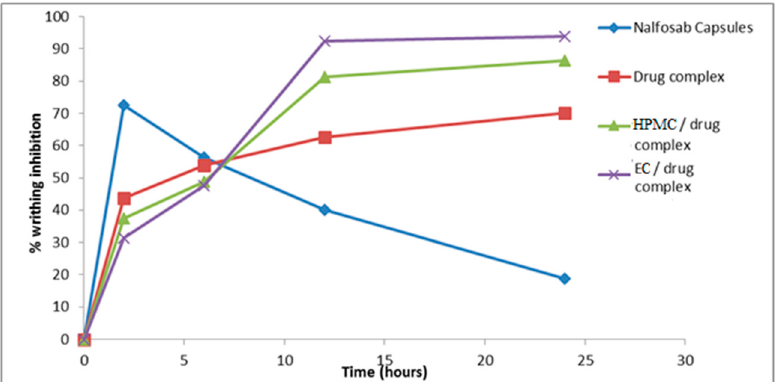
Figure 10. Mean % inhibition of induced abdominal writhing by Nalfosab Capsules, drug complex, HPMC/drug complex and EC/drug complex.